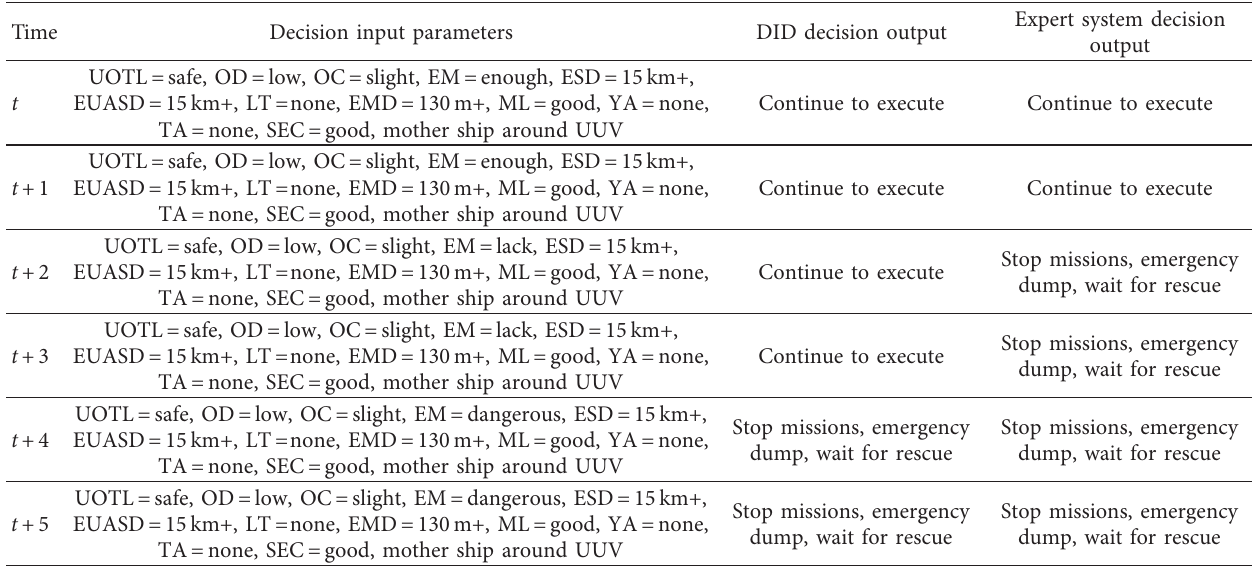
Table 11: A comparison of the decision outputs from the DID and expert systems.